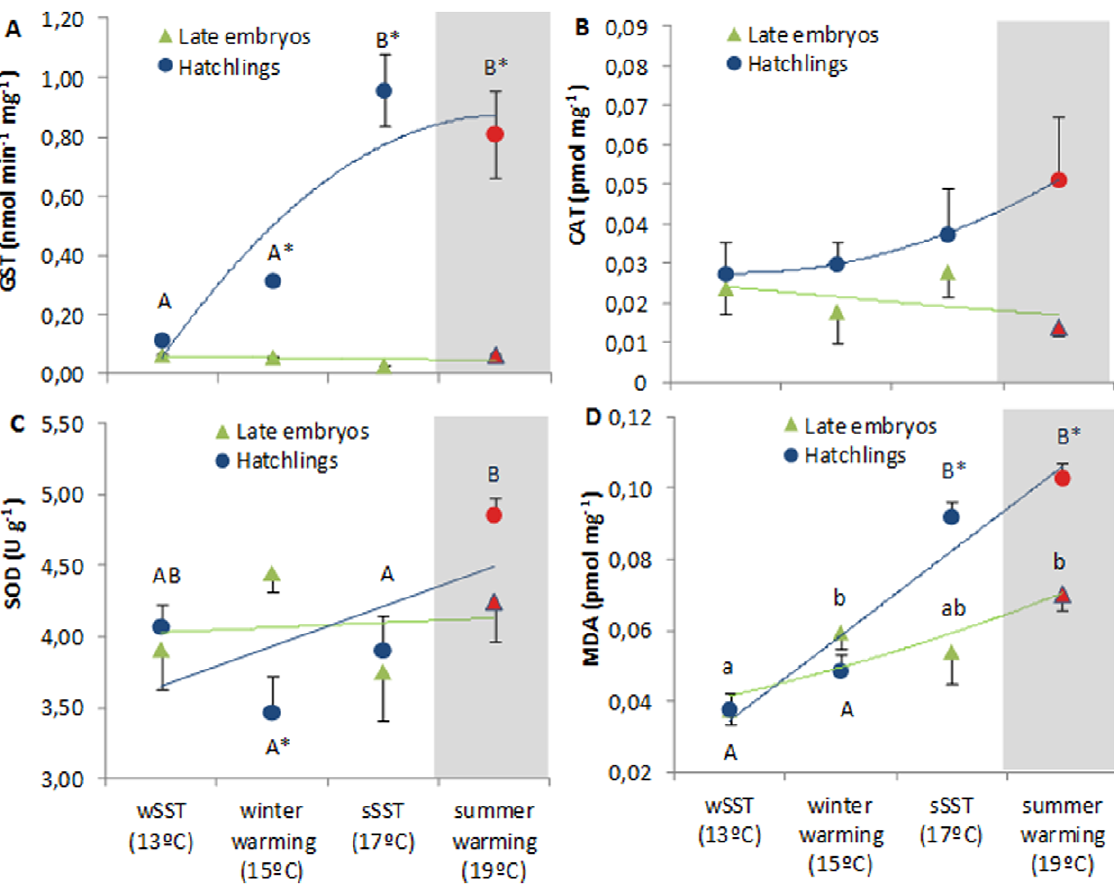
Figure 7. Antioxidant response of Loligovulgaris ’ late embryos and hatchlings at the different temperature scenarios: A) GST (nmol min 2 1 mg 2 1 ), B) CAT (pmol mg 2 1 ), C) SOD (U g 2 1 ) and d) malondialdehyde (MDA; pmol mg 2 1 ). Red symbols highlight the future summer scenario. Values are mean 6 SD. Colored lines represent trendlines and different letters (capital letters for hatchlings; small letters for embryos) and asterisk represent significant differences between temperatures and developmental stages, respectively (more statistical details in Supporting Tables).